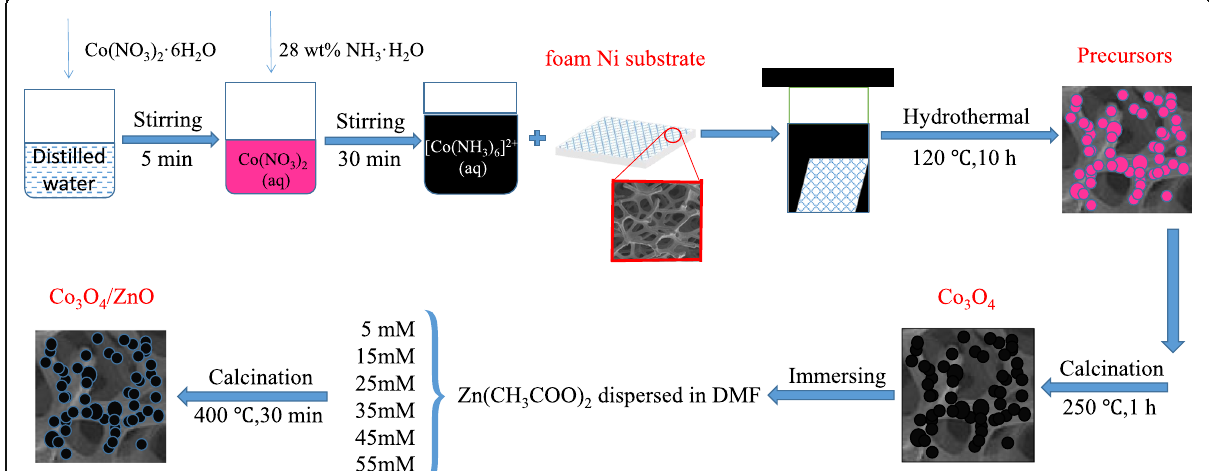
Fig. 1 Schematic representation of the fabrication process of p -Co 3 O 4 / n -ZnO